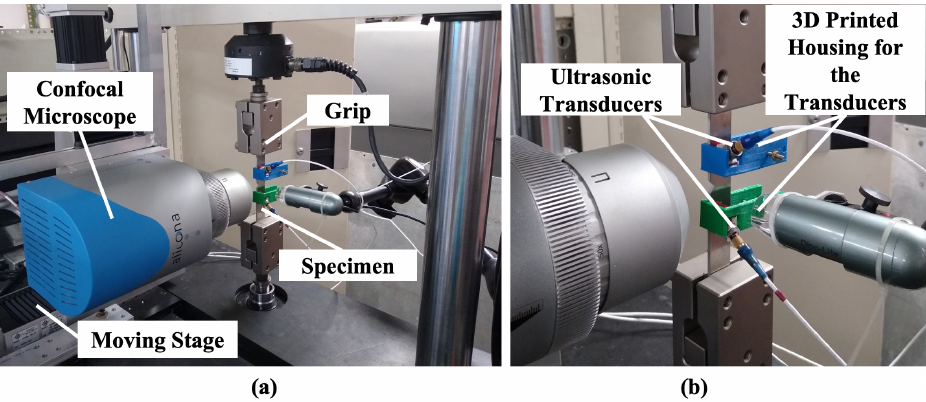
Figure 5. ( a ) Custom fatigue testing apparatus highlighting the specimen, confocal microscope, moving stage, and grips. ( b ) Ultrasonic sensors mounted with a 3D-printed housing on the specimens. Reprinted from [27] with permission under the terms and conditions of the Creative Commons Attribution (CC BY)